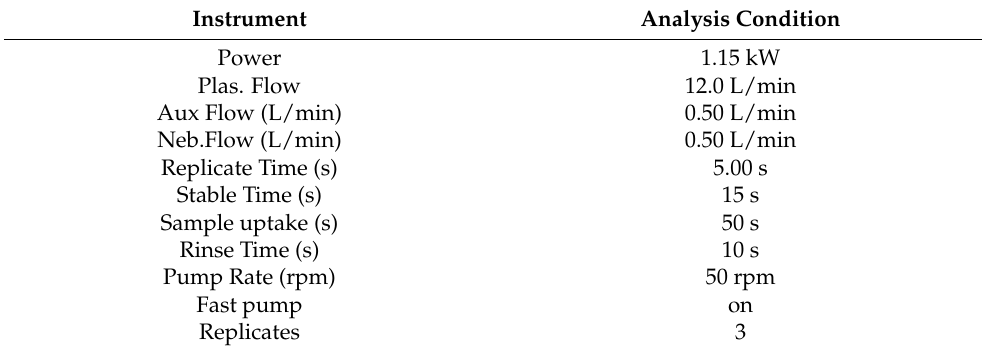
Table 1. Analysis conditions of ICP-OES.